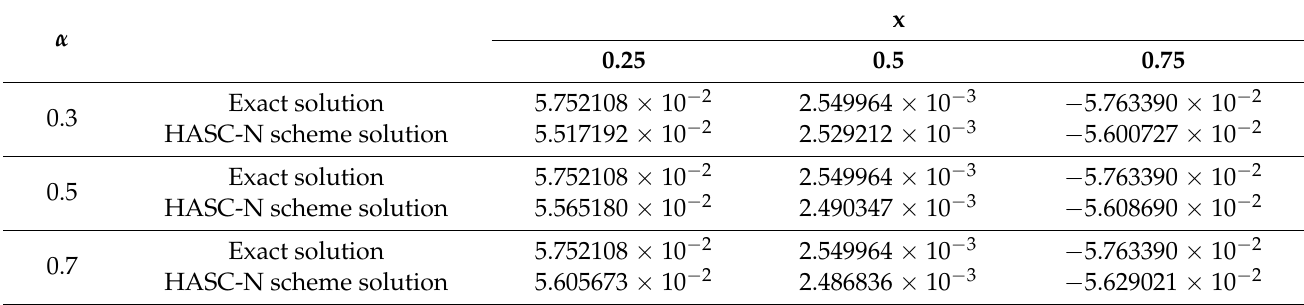
Table 1. Comparison between exact solution and HASC-N scheme solution for Example 1 ( t = 0.5).